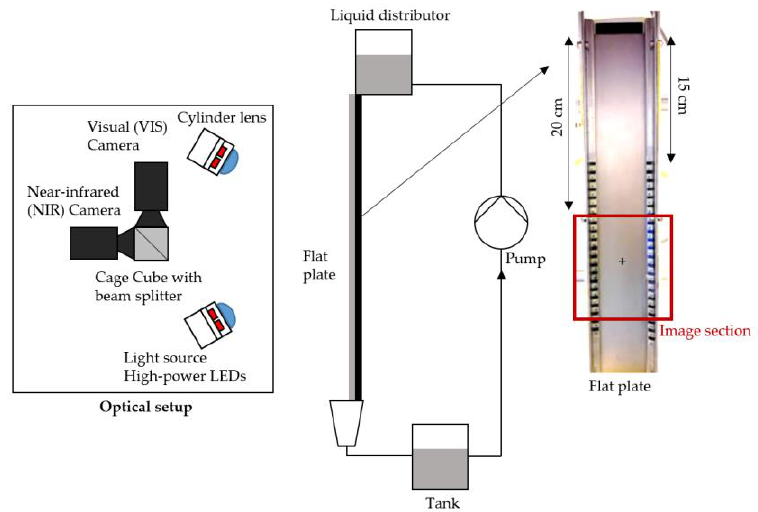
Figure 3. Schematic of the experimental setup for the local investigation of falling films. . m , the kinematic viscosity ν , the density ρ , and Parameters such as the mass flow rate the plate width of falling film B F determine the Reynolds number, see Equation (2). The pump worked with a volume flow rate between 150 and 1450 mL/min in the